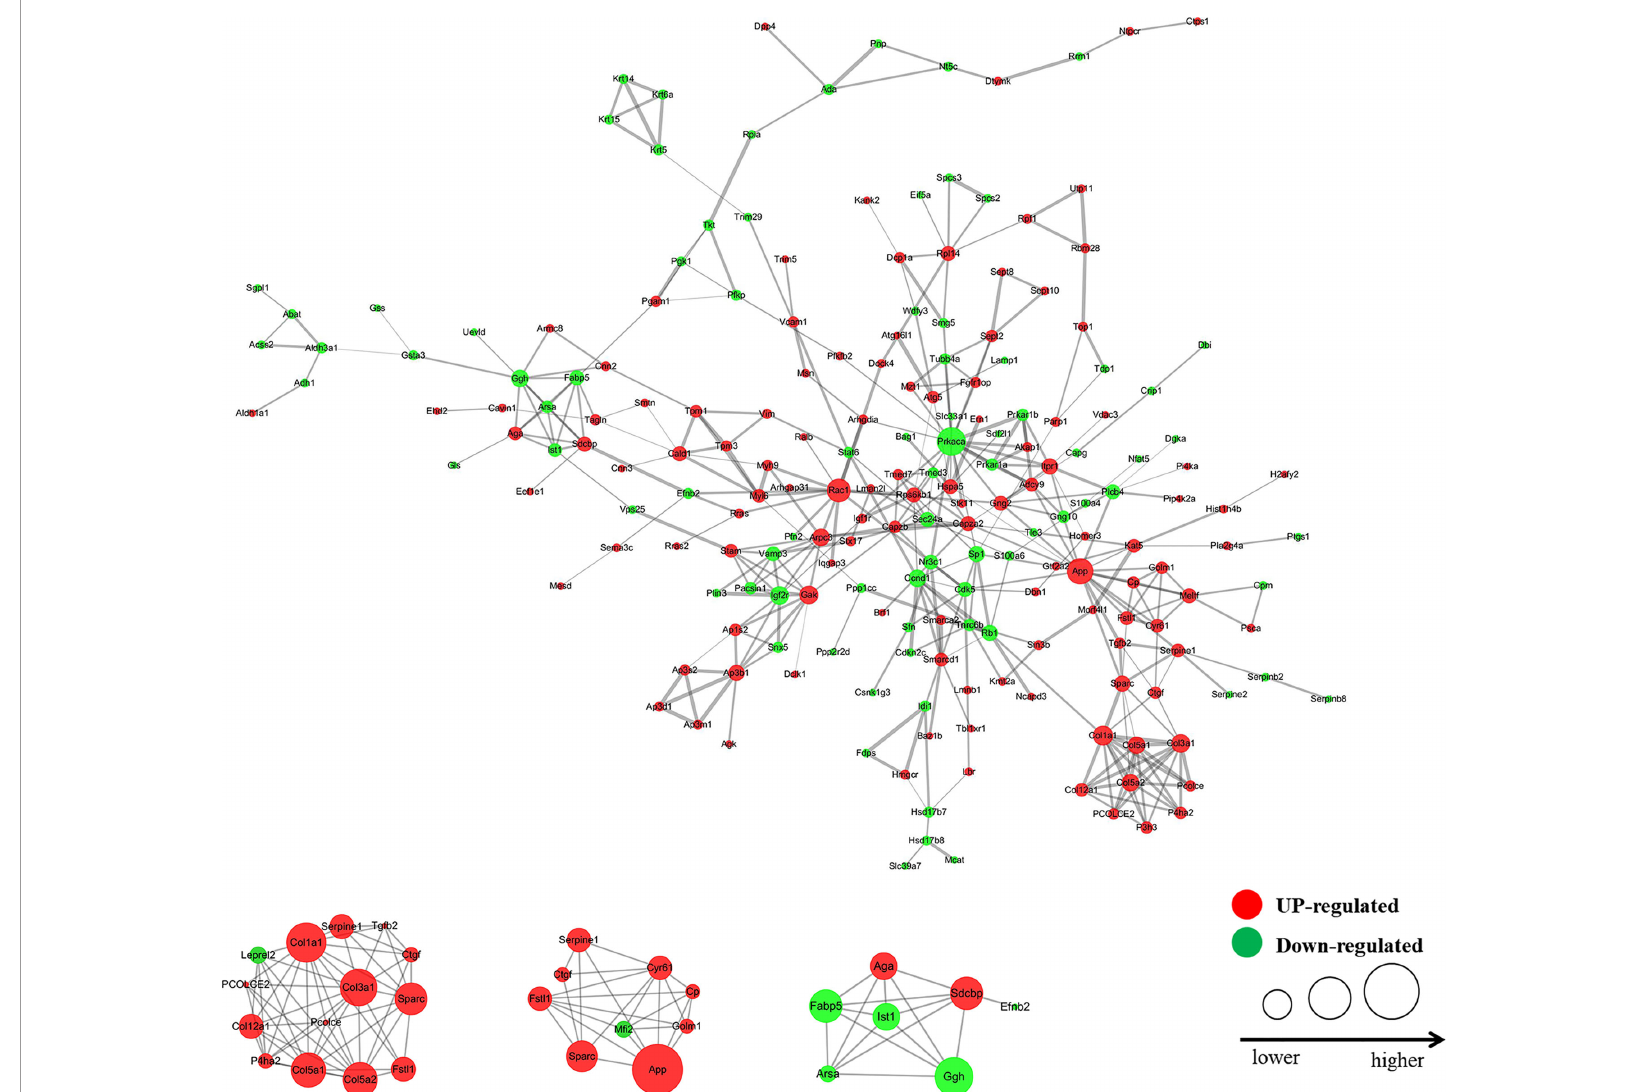
FIGURE 3 | Interaction network diagram of the protein with fold change >1.3 (VHL shRNA/WT). The interactive network of 83 proteins and their differential expression in the VHL-KD cells vs those in the empty vector-transfected